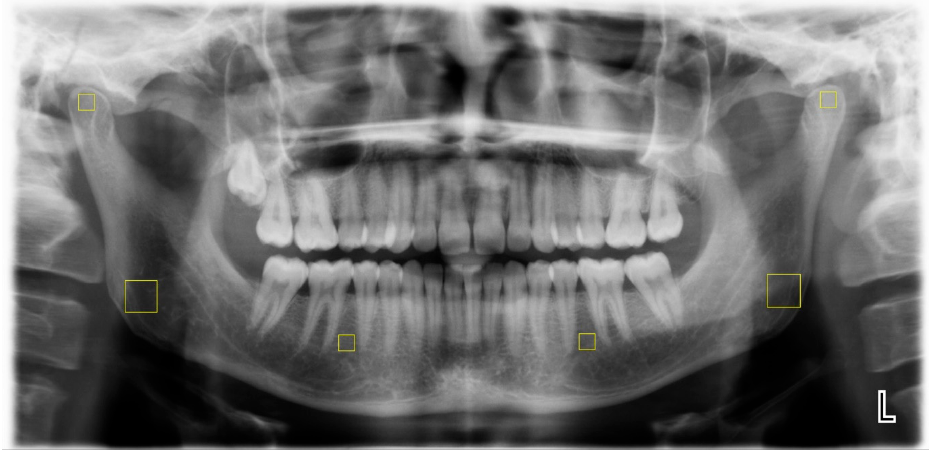
Figure 1. Selection of ROIs (marked by yellow squares).